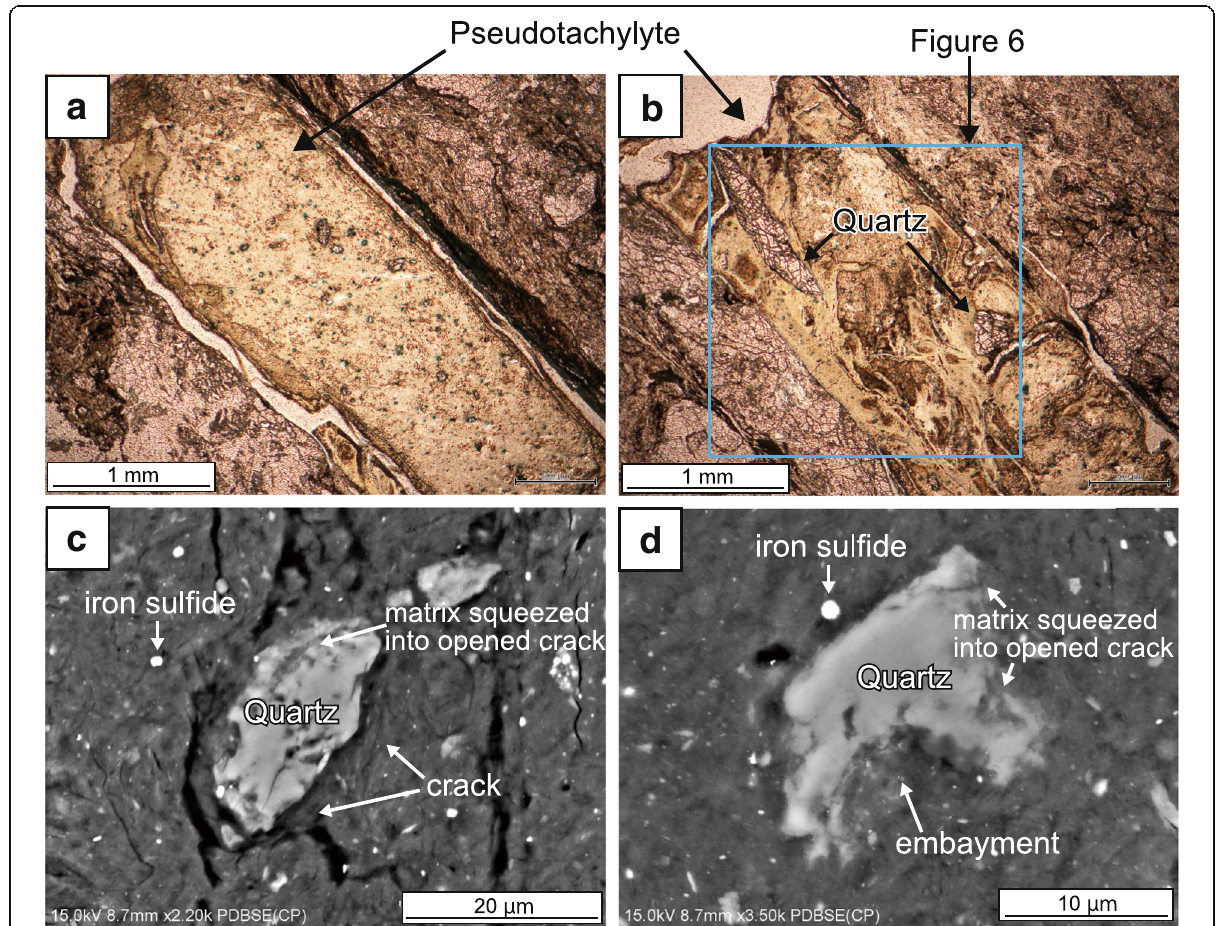
Fig. 5 Microstructure of pseudotachylyte. a , b Open-polarized photomicrographs of pseudotachylytes and blackened zone, respectively. Note that quartz fragments were strongly cracked, and the matrix shows flow texture. c , d FE-SEM images of pseudotachylyte. Quartz particles appearing in both images were eroded, cracked, and embayed. Numerous tiny iron sulfide particles occur in the